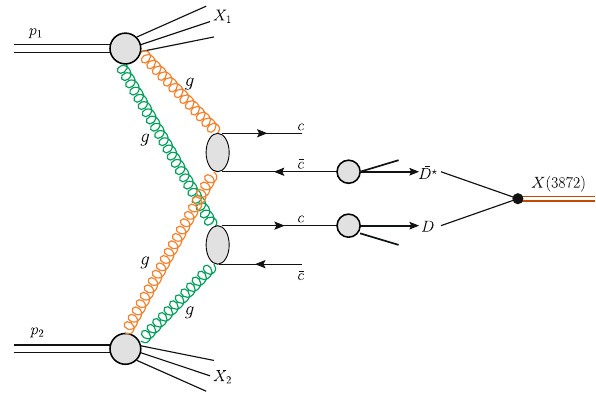
Fig. 2 Agenericdiagramfortheinclusiveprocessof X ( 3872 ) produc- tion in proton–proton scattering via the double parton scattering mode